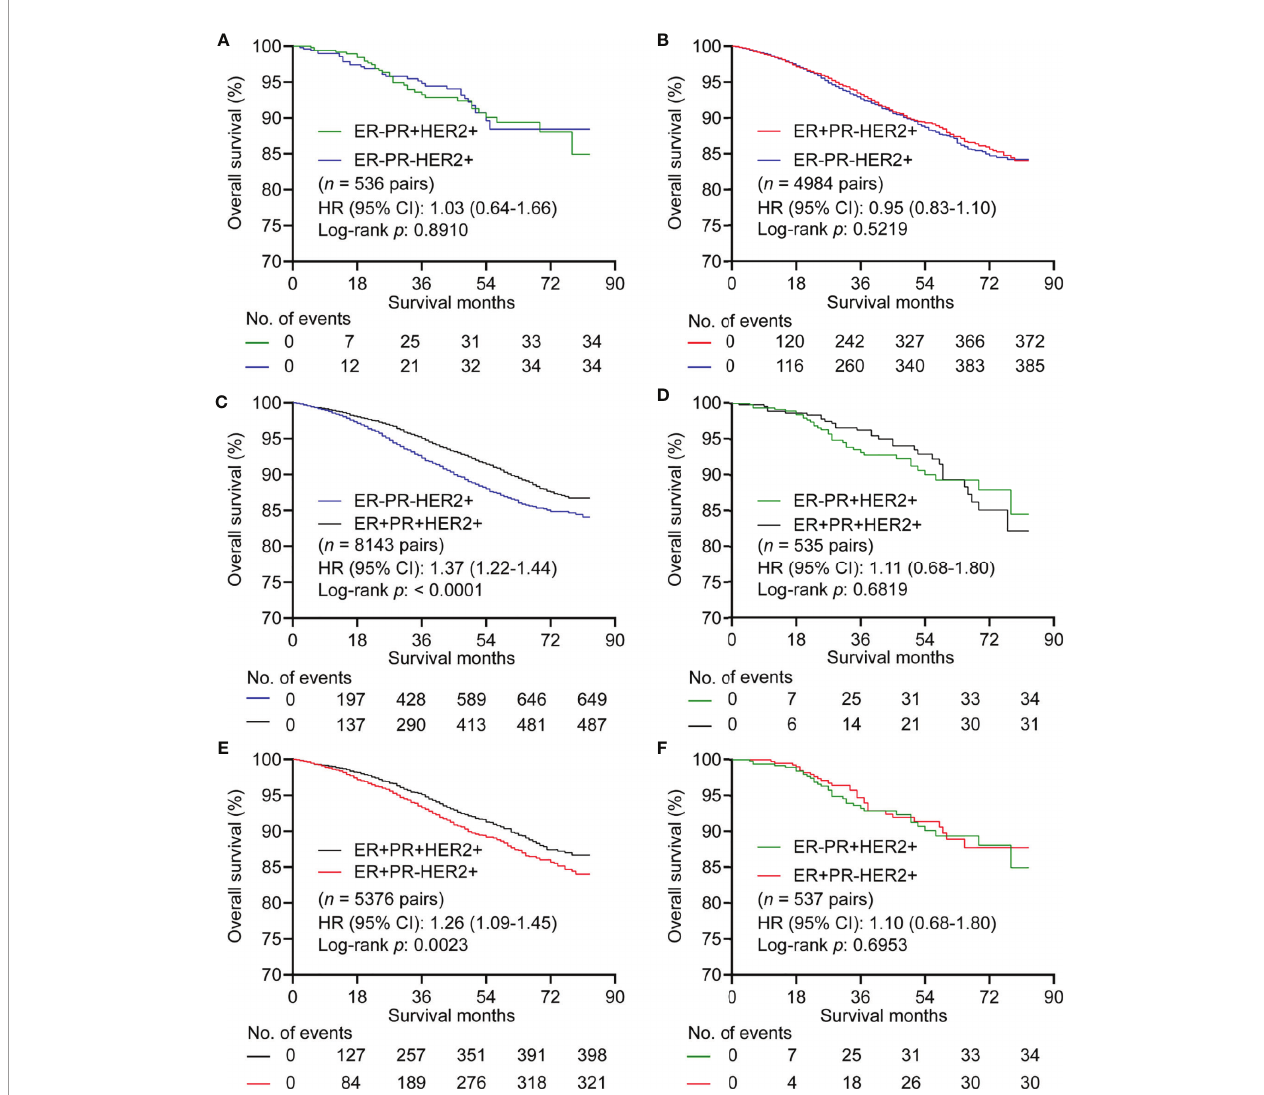
FIGURE 3 | Kaplan – Meier curves of overall survival in HER2+ subgroup after propensity score matching. (A) Comparison between ER-PR+ and ER-PR-. (B) Comparison between ER+PR- and ER-PR-. (C) Comparison between ER-PR- and ER+PR+. (D) Comparison between ER+PR+ and ER-PR+. (E) Comparison between ER+PR+ and ER+PR-. (F) Comparison between ER+PR- and ER-PR+. ER, estrogen receptor; PR, progesterone receptor; HER2, human epidermal growth factor Receptor